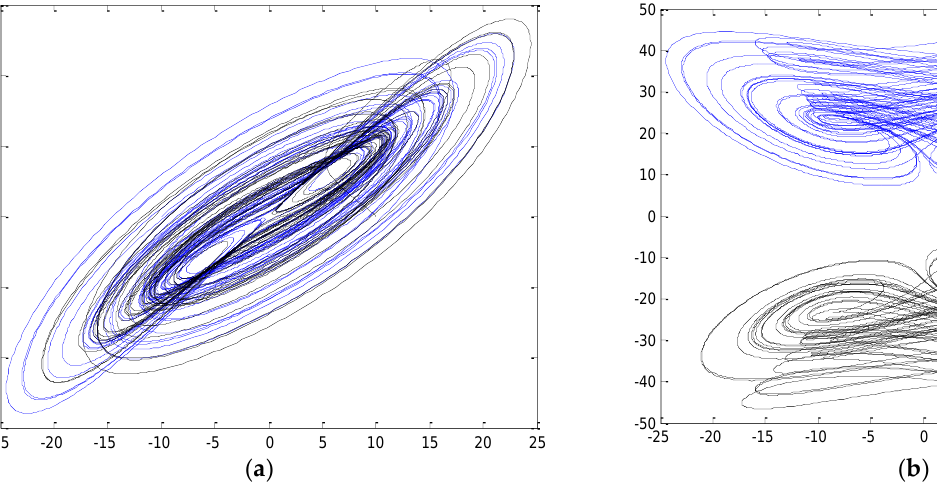
Figure 10. Time-delay fractional order derivative, with 𝛼 = 0.9,𝛼 = 0.8 and 𝛼 = 0.5 , time delay 𝜏 = 5 s . Graphs of synchronization (𝐚) 𝜎, (𝐛) 𝜌,(𝐜) 𝛽 values of slave systems. As the second part of our research, we also considered the time-delay anti-synchro- nization of the same abovementioned systems, using the previously described fractional- order PID-type control law and the stability analysis is obtained by means of the stability analysis by Lyapunov. When applied to system (4) (Lorenz system), it forces the time-delay anti-synchronize with the Chen ’ s system (3). Figure 11 with 𝛼 = 0.9 shows the phase portraits for the time-delay anti-synchroniza- tion between Chen and Lorenz chaotic systems and Figure 12 shows the fractional varia- ble order derivative with 𝛼 = 0.9, 𝛼 = 0.8, and 𝛼 = 0.5.